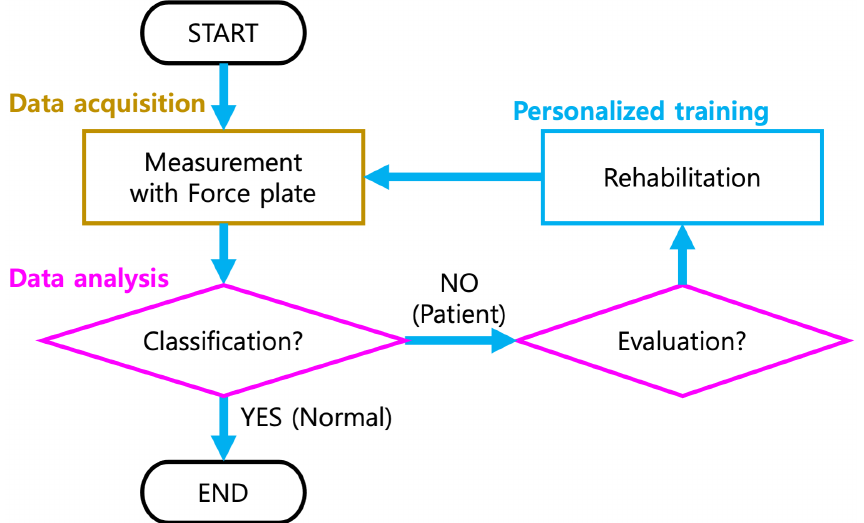
Figure 2. A three-step flow chart for the rehabilitation of patients after the surgery: first, data acquisition to measure data with the force plate, then data analysis to classify whether the gait pattern of the patient is close to the standard group or not and to recognize in which step the abnormality has occurred, and finally personalized training to improve the gait